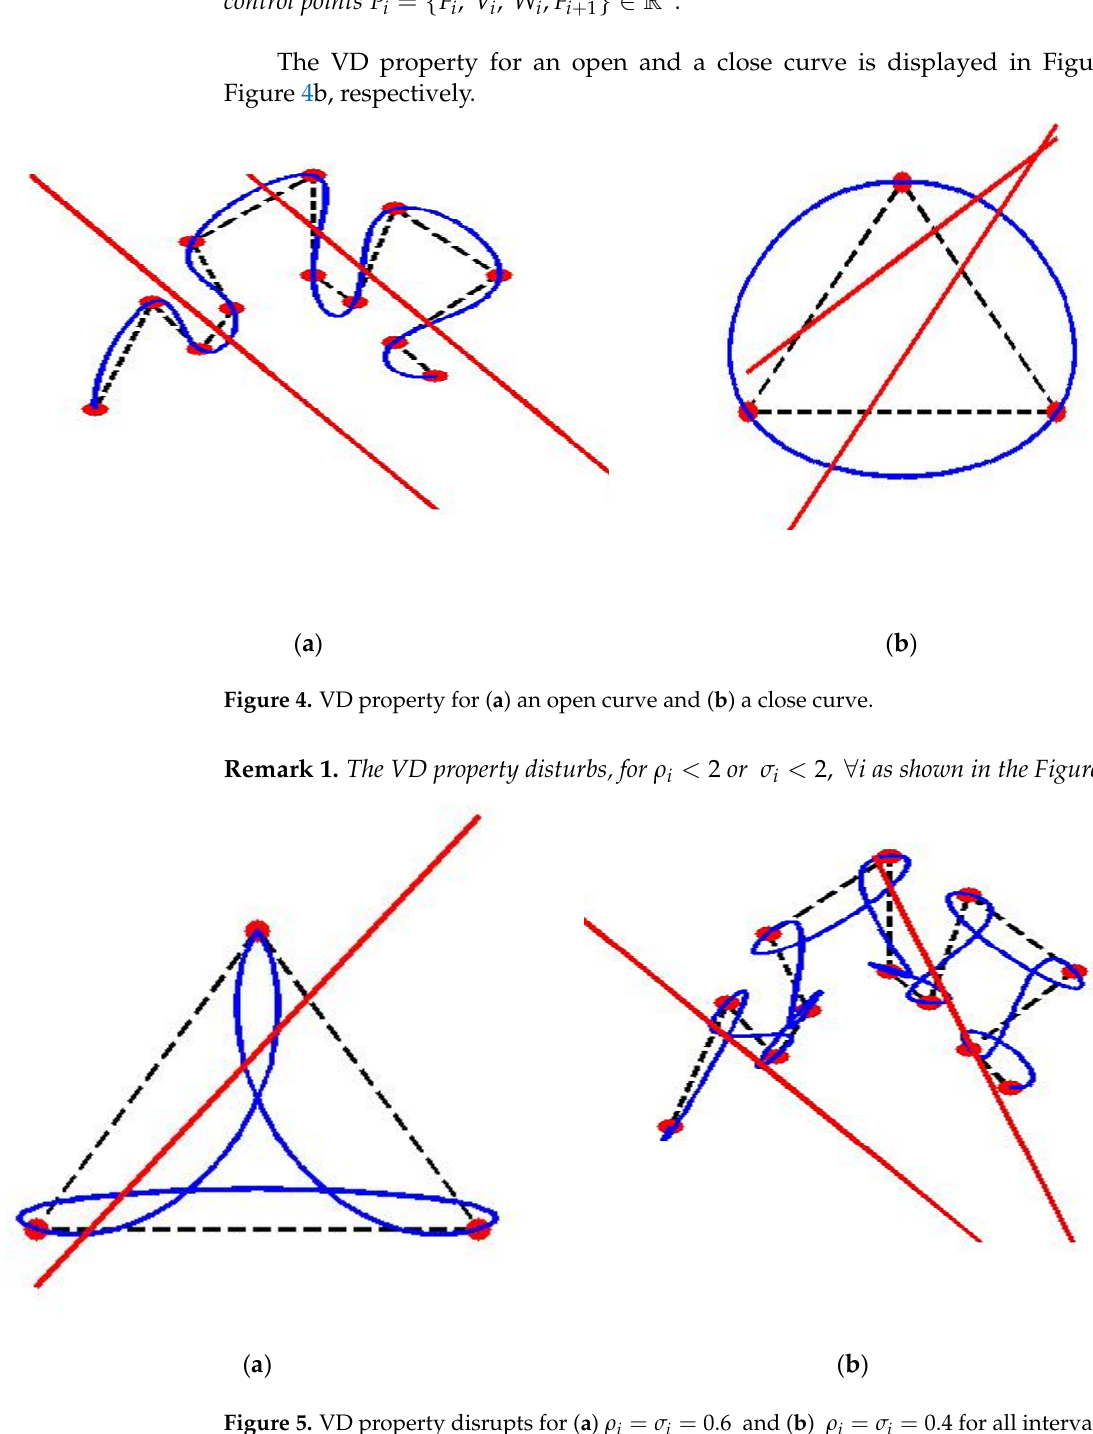
= σ = 0.6 and ( b ) ρ = σ = 0.4 for all i i i i